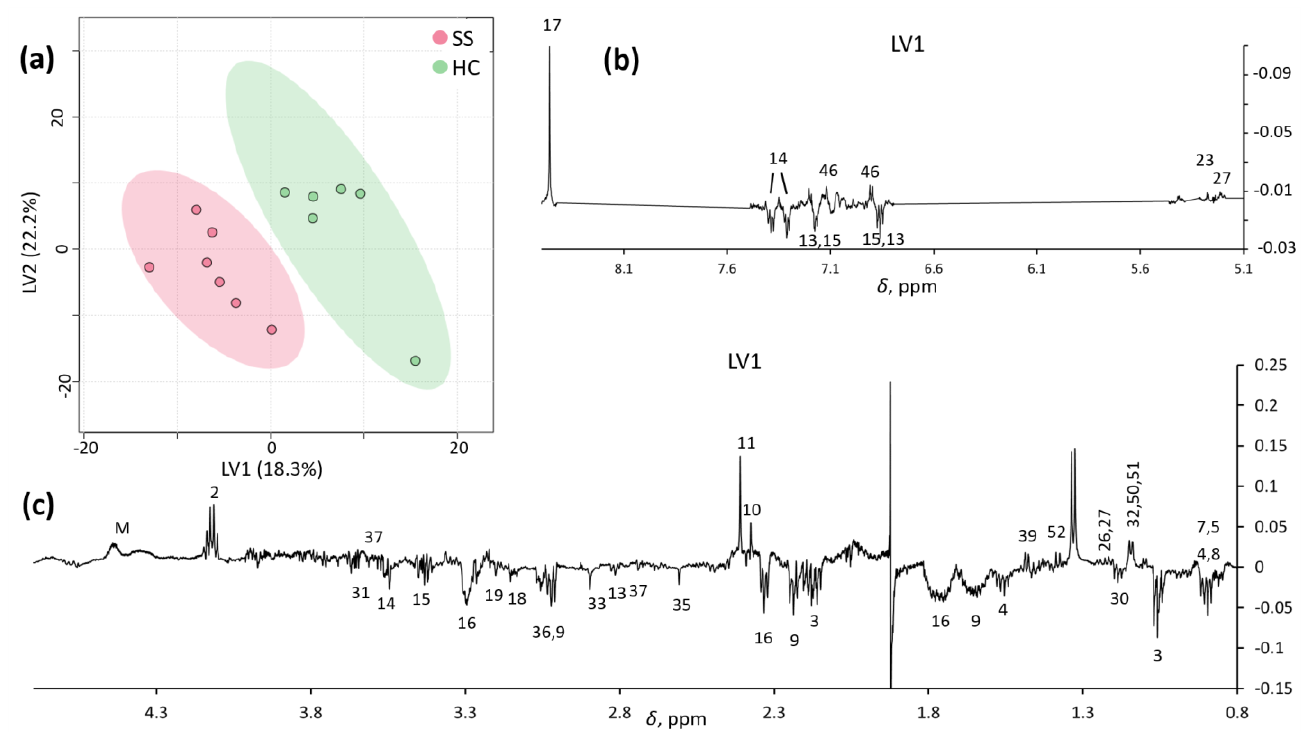
Figure 3. LV1/LV2 score plot ( a ) and loading profiles ( b , c ) obtained by PLS-DA on spectra. Table 2. Most significant metabolites in each group (red, pSS; green, HCs) obtained by PCA and PLS-DA from 1 H-NMR CPMG NMR spectra.